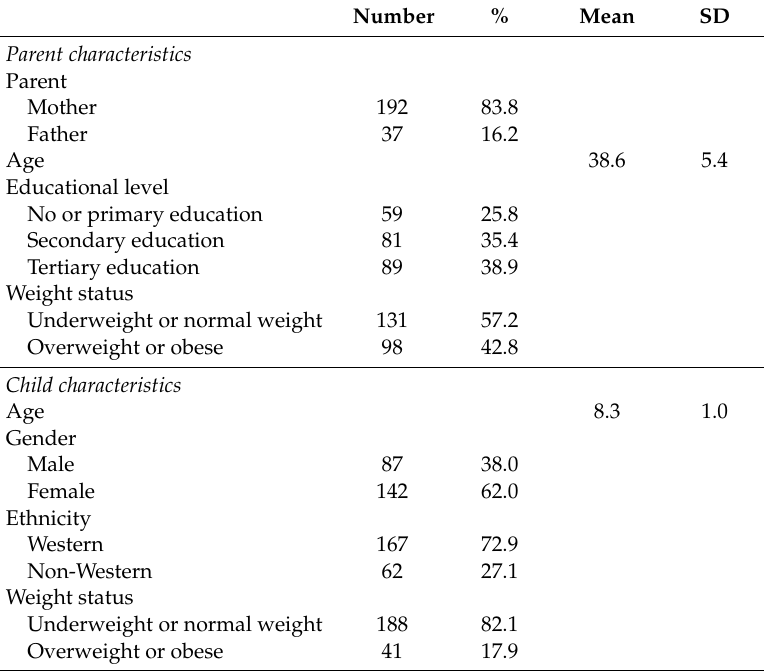
Table 1. Characteristics of the target population ( N =